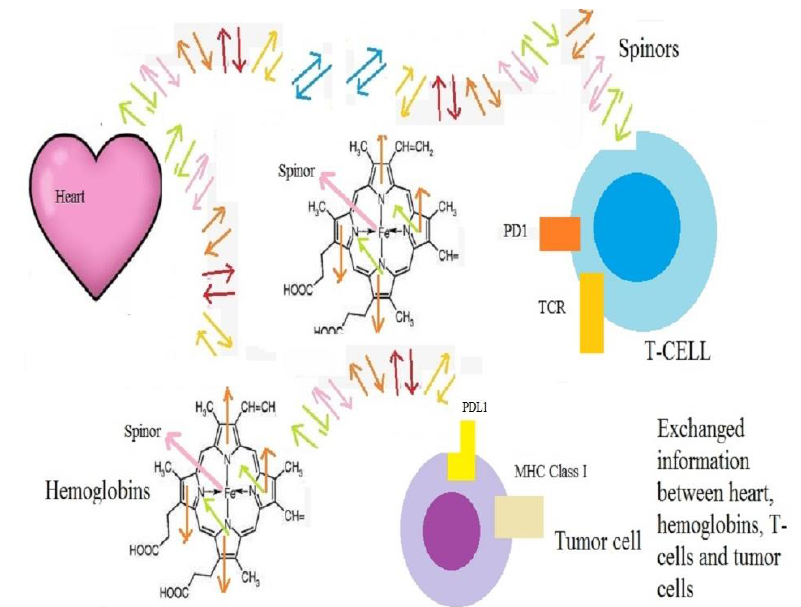
Figure 6. Induction of information within biological structures, such as proteins by hemoglobin—a hypothesis.